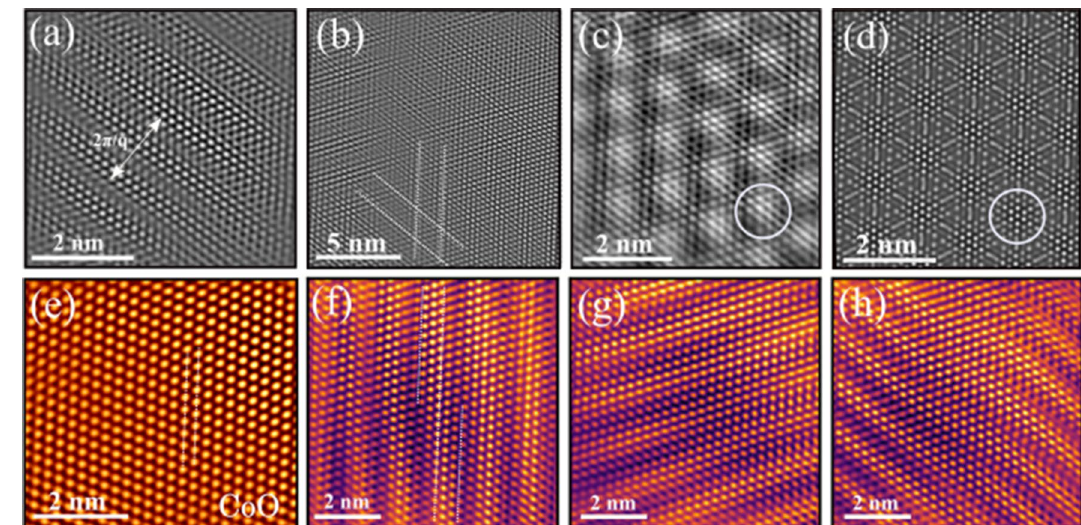
Figure 2. Real-space distribution of local electronic-phase inhomogeneity in CoO. ( a , b ) Unidirectional and bidirectional stripe patterns of the charge density modulation in CoO. ( c ) Intensity modulation of a segregated charge density in CoO. ( d ) Simulated HR-TEM image of Co 1 − x O shows a close similarity with ( c ) the experimental HR-TEM. The circles indicate the equivalent location of a segregated density in the experimental and simulated HR-TEM image, respectively. ( e ) HR-TEM image of the unperturbed lattice of CoO. ( f – h ) Bending and breaking nature of CO